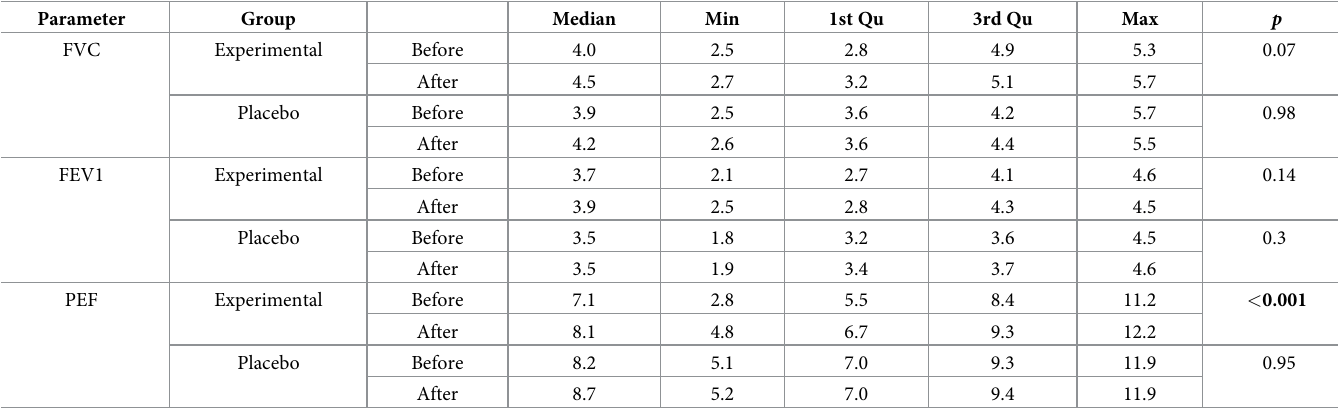
Table 2. Pulmonary parameters before and after OMT and STT observed in experimental and placebo groups. Parameter Group Median FVC Experimental Before Placebo Before After FEV1 Experimental Before